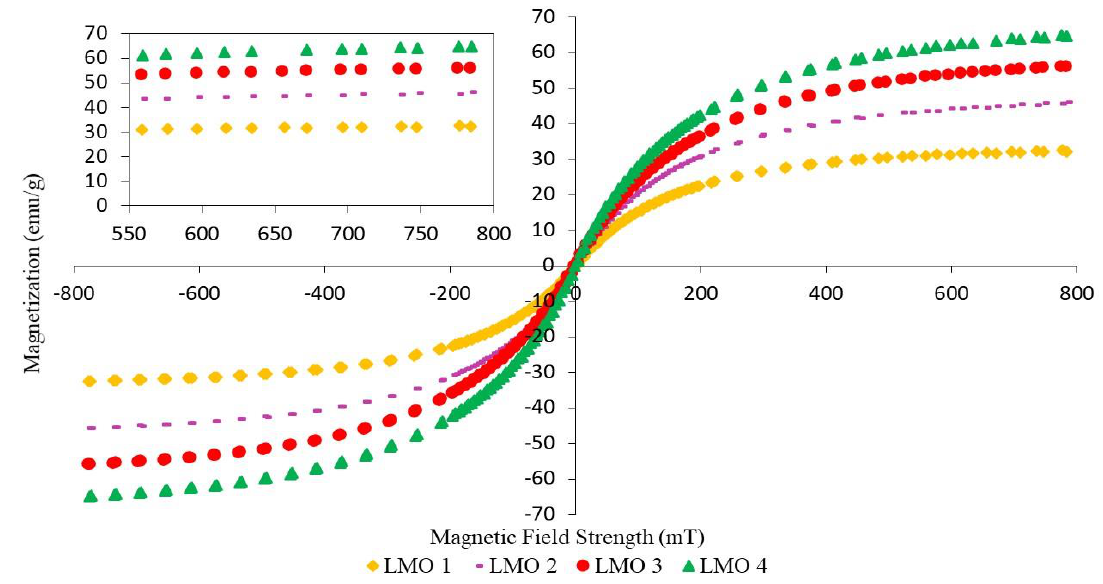
Figure 8. Magnetization curves of NR-based MREs for different ratios of LMO:AO. The magnetization curves for MRE samples with different ratios of PO:AO are shown in Figure 9. PO 1 shows the lowest magnetic saturation in the absence of the AO content. Meanwhile, PO 3 represents the highest value of magnetic saturation as compared to PO 1, PO 2, and PO 4. PO 3 might be the best ratio for magnetic properties due to the interaction of PO and AO when mixed one another at a ratio of 50:50.